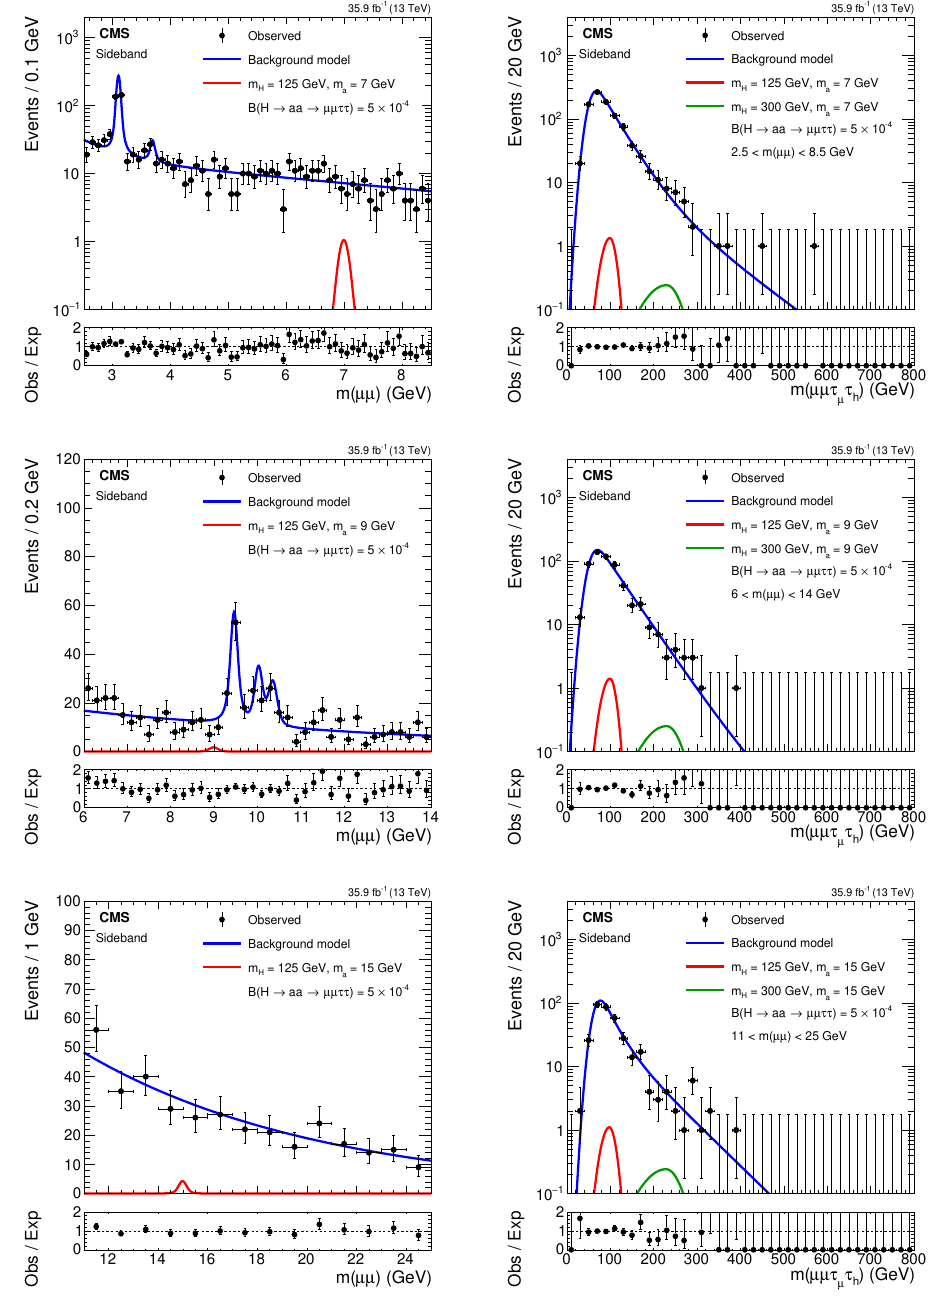
Figure 4 . Projections of 2D background model (cid:12)ts and observed data in the sideband on the m ( (cid:22)(cid:22) ) (left), and m ( (cid:22)(cid:22)(cid:28) (cid:28) ) (right) axes with sample signal distributions that assume H boson masses (cid:22) h of m = 125 and 300 GeV. The (cid:12)gures are divided into three (cid:12)t ranges: 2 : 5 < m ( (cid:22)(cid:22) ) < 8 : 5 GeV H (upper), 6 < m ( (cid:22)(cid:22) ) < 14 GeV (middle), and 11 < m ( (cid:22)(cid:22) ) < 25 GeV (lower).